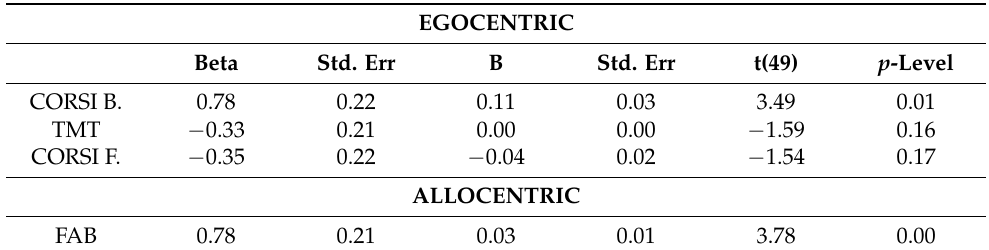
Table 4. The upper part of the table shows the relationship between AD patients’ performance at Corsi Backward, Corsi Forward and TMT (predictors) and accuracy of Egocentric judgments; the lower part of the table shows the relationship between participants’ performance at FAB and accuracy of allocentric judgments. The multiple regression parameters are